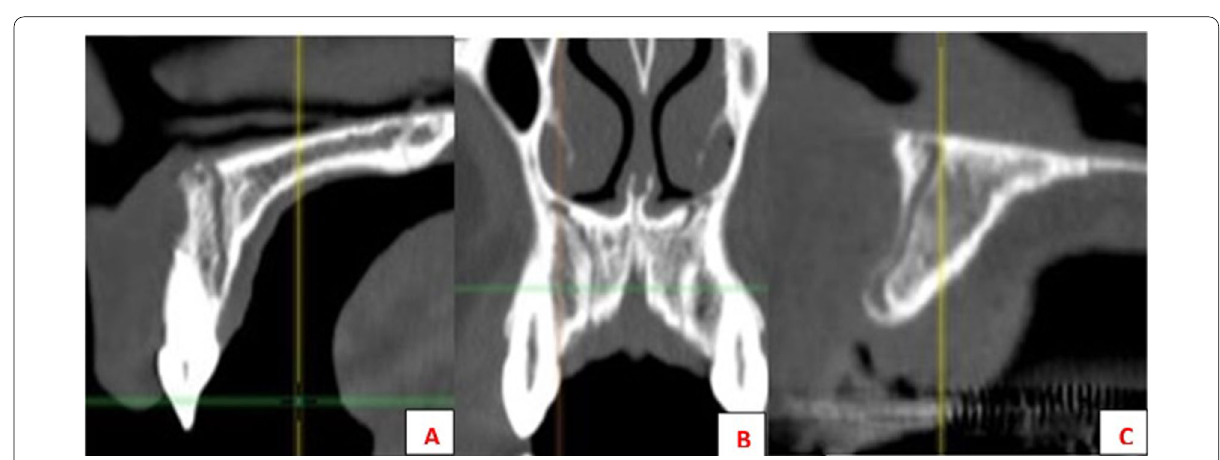
Fig. 7 CS branches at different locations: Parallel to central incisor ( A ); Canine area bilaterally ( B ); Alveolar crest ( C